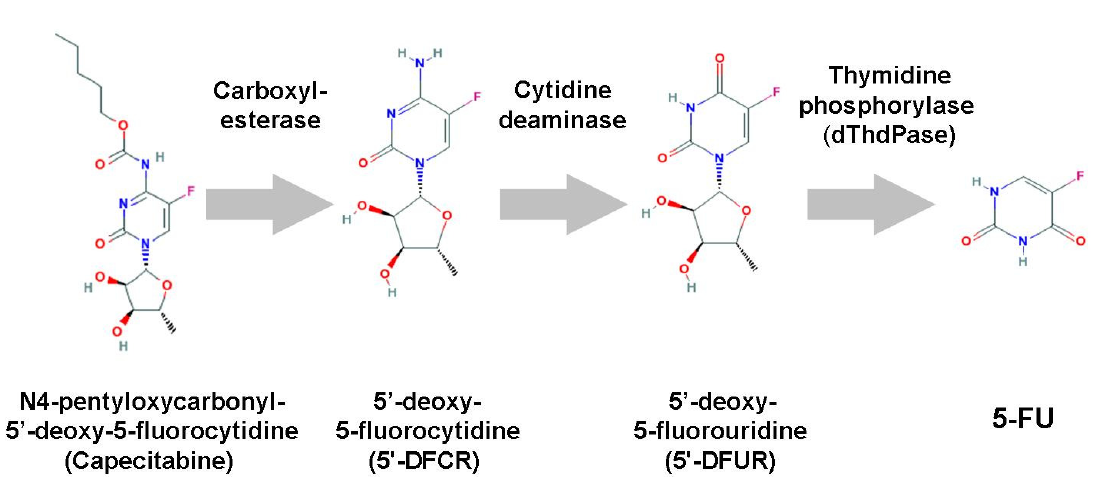
Figure 4. The metabolism of